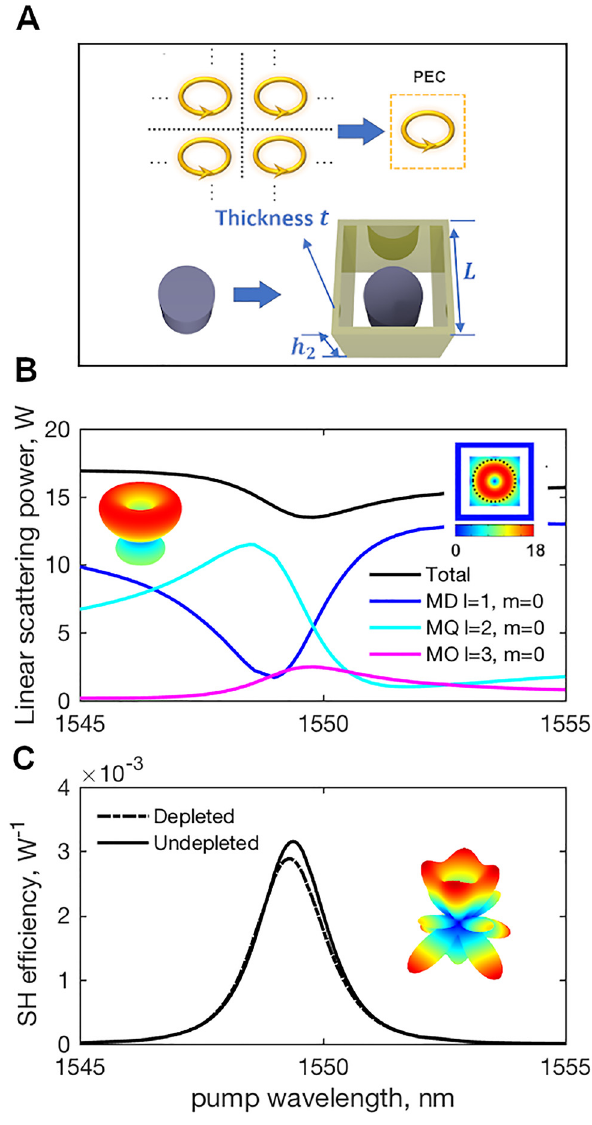
Figure 8: (A) Top: Schematic of the equivalent transformation betweencircular polarizationcurrentsexcited in a periodic latticeof MD resonators and currents excited in a single MD resonator surroundedbyPECstructures.Bottom:Thetransformationfroma2D periodic array of MD resonators to an isolated nanostructure composed of an MD resonator surrounded by gold nanobars. (B) Linear scattering and its multipolar decomposition for the hybrid AlGaAs-disk-with-Gold nanostructure under AP pump illumination. (C) SHG efficiency calculated using the undepleted pump model (solid line) and the coupled nonlinear model with back-action